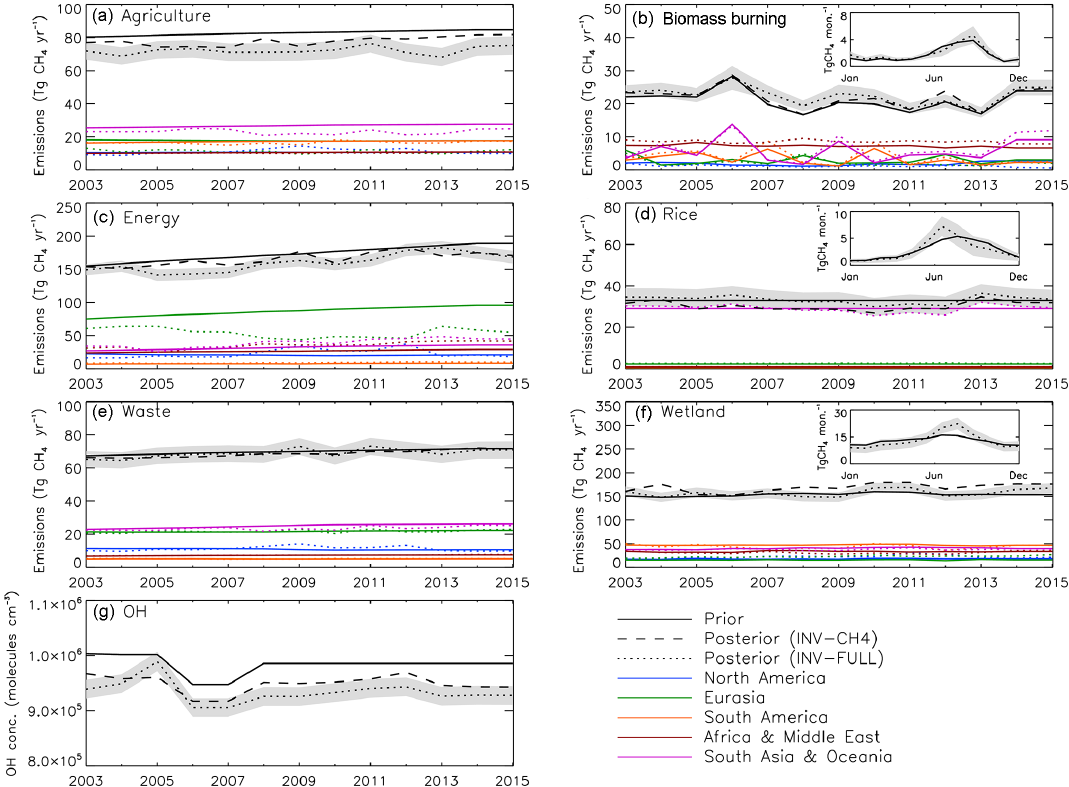
Figure 6. (a–f) Annual CH 4 emissions (TgCH 4 yr − 1 ) from different sectors for global prior (black solid line), INV-CH4 (black dashed line), and INV-FULL posterior (black dotted line) estimates. Regional estimates are also displayed for North America (blue), Eurasia (green), South America (orange), Africa and the Middle East (red), and South Asia and Oceania (purple). (g) Prior and posterior global OH estimates for the same period. Shaded region denotes posterior error A for INV-FULL (see Eq. 5 in text). Table 7. Suite of inversion sensitivity experiments with varying errors on source and sink